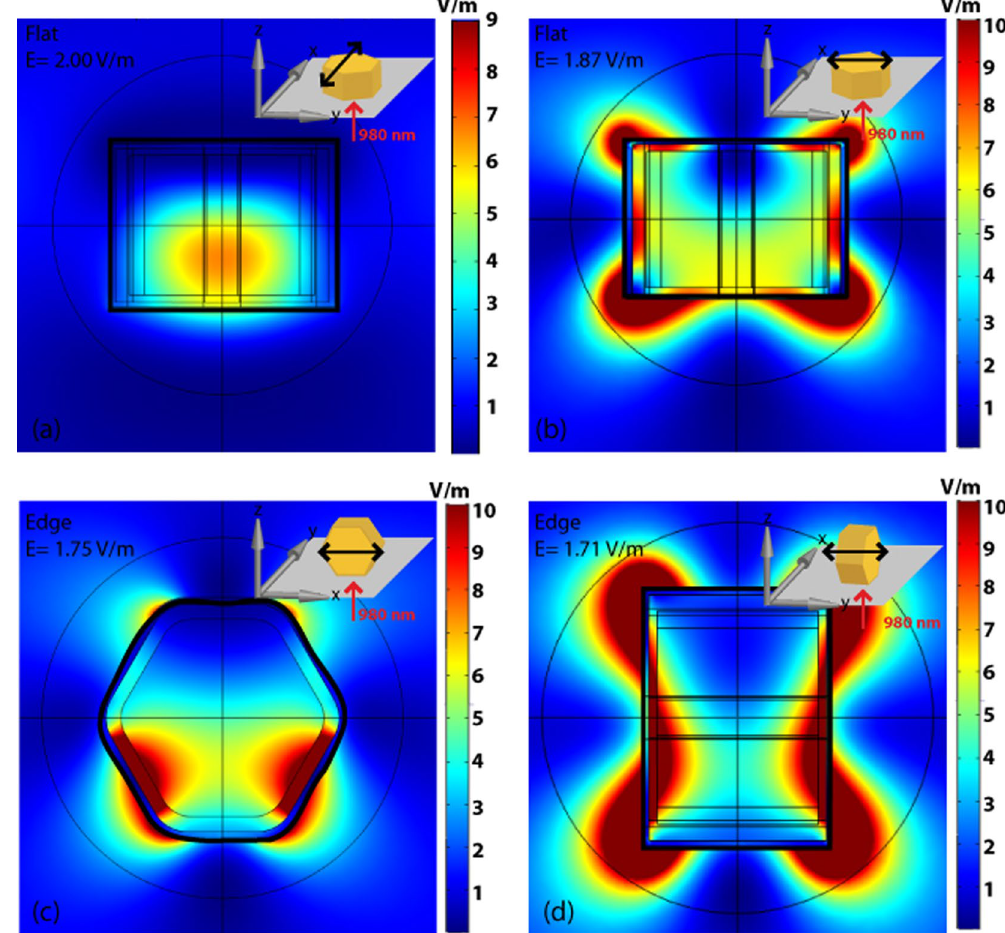
Figure 3. Plots of the volume averaged square of the electric field strength of flat ( a and b ) and edge orientation ( c and d ) at 0° (x-polarized, a and c ) and 90° (y-polarized, b and d ) excitation polarization. The direction of the incident light is shown by the red arrow. The orientation of the polarization is shown by the black